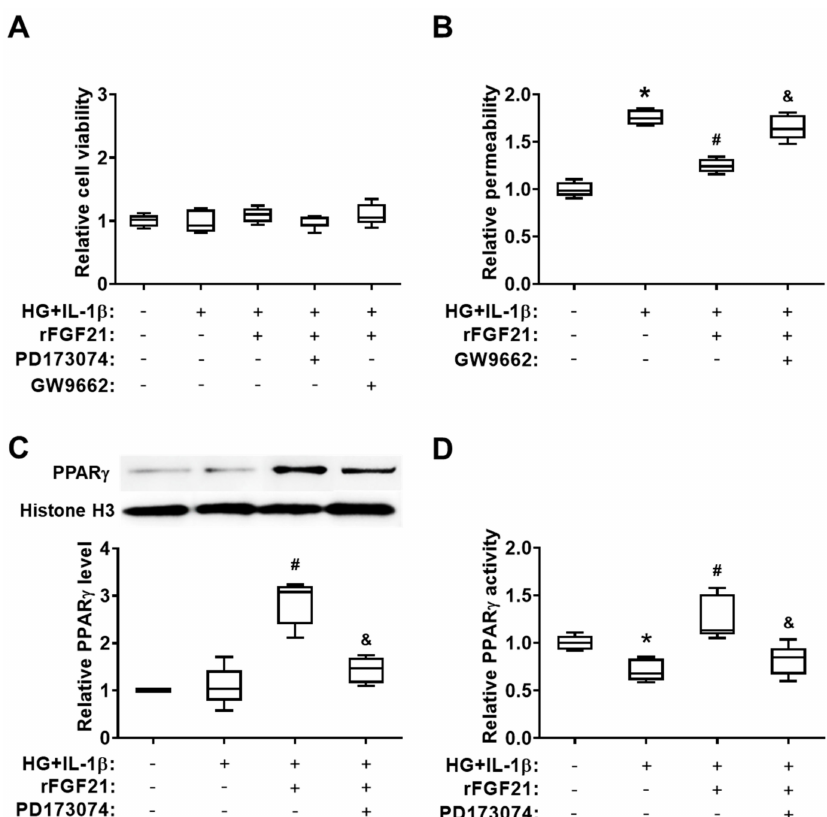
Figure 4. rFGF21 ameliorates transendothelial permeability via promoting FGFR1-mediated PPAR γ activity in cultured human brain microvascular endothelial cells (HBMECs). HBMECs were